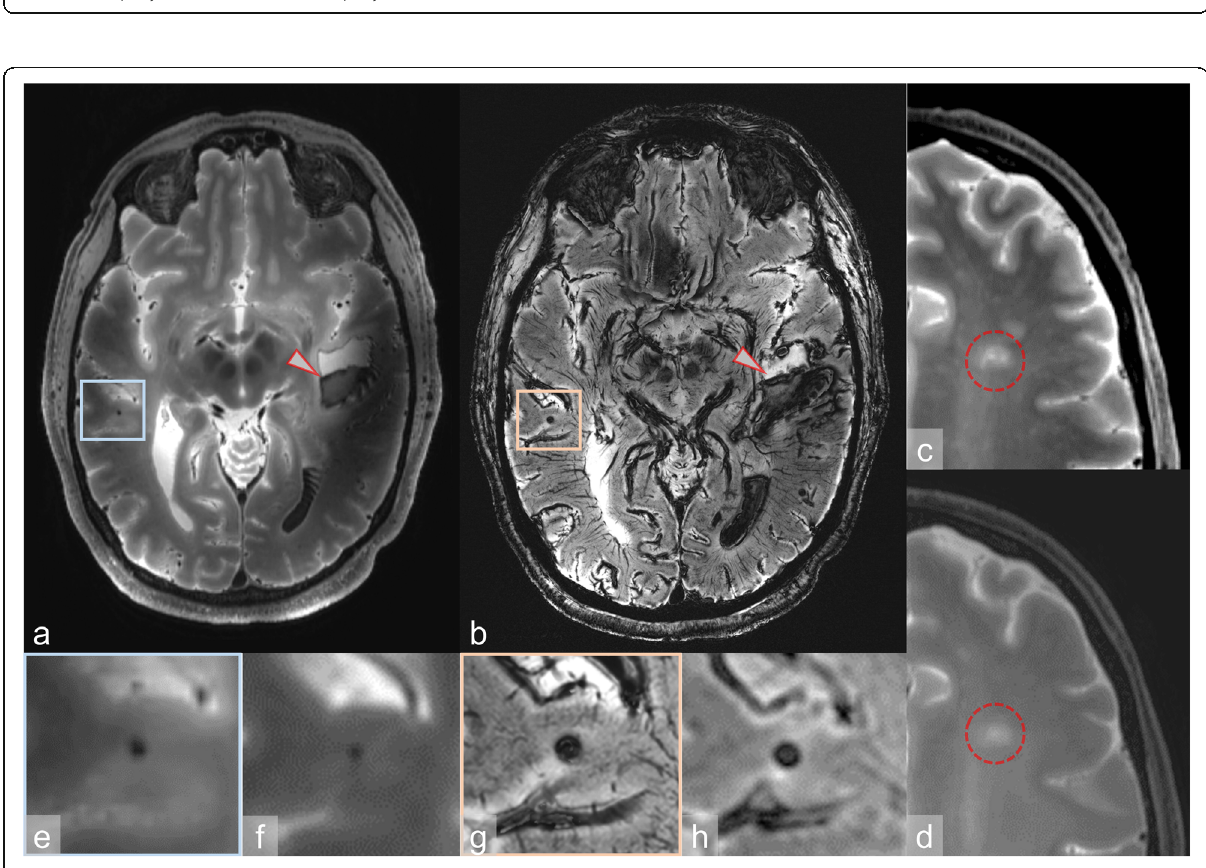
Fig. 2 a-d Case 1. 7-T T2-weighted images demonstrate coup injuries ( a , b ) and contrecoup injuries ( c , d ). 3-T T2-weighted images appear blurred for both coup injuries ( e ) and contrecoup injuries ( f )